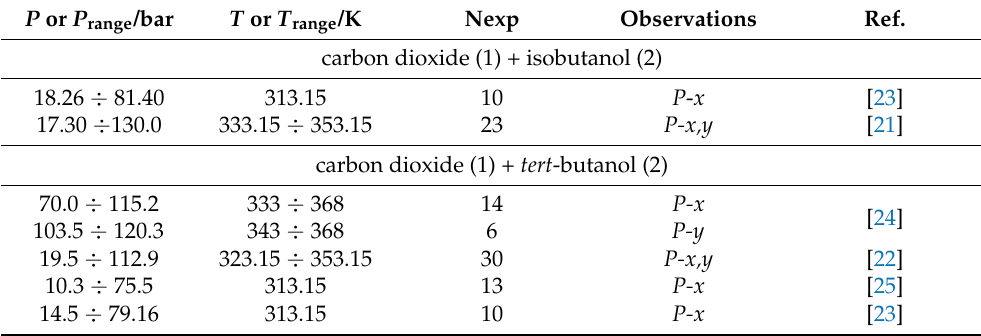
Table 1. Literature a VLE experimental data for carbon dioxide + isobutanol and + tert -butanol. P or P range /bar T or T range /K Nexp Observations